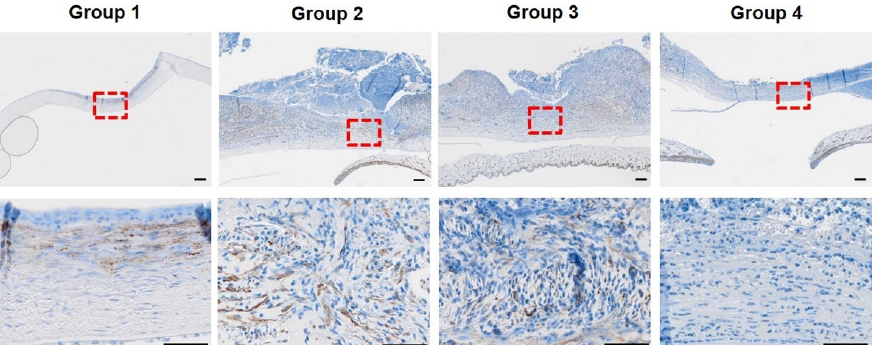
Figure 6. The neutrophils in the corneal stroma were counted at the high-power field. Neutrophils were increased in all groups except group 1, and group 3 showed a lower value than groups 2 and 4. n = 8 in groups 1, 2, and 4; and n = 9 in group 3. *, p ≤ 0.05 .